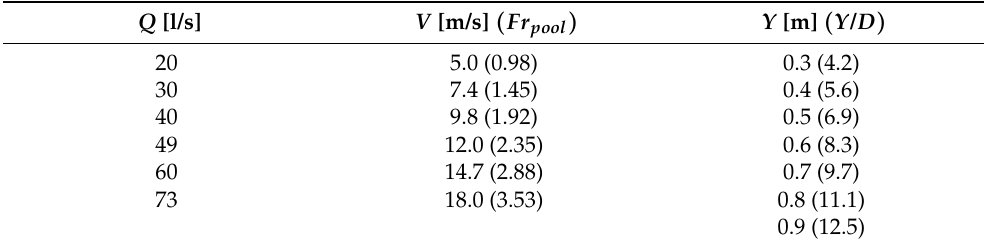
Table 1. Test program varying discharge Q and pool depth Y (42